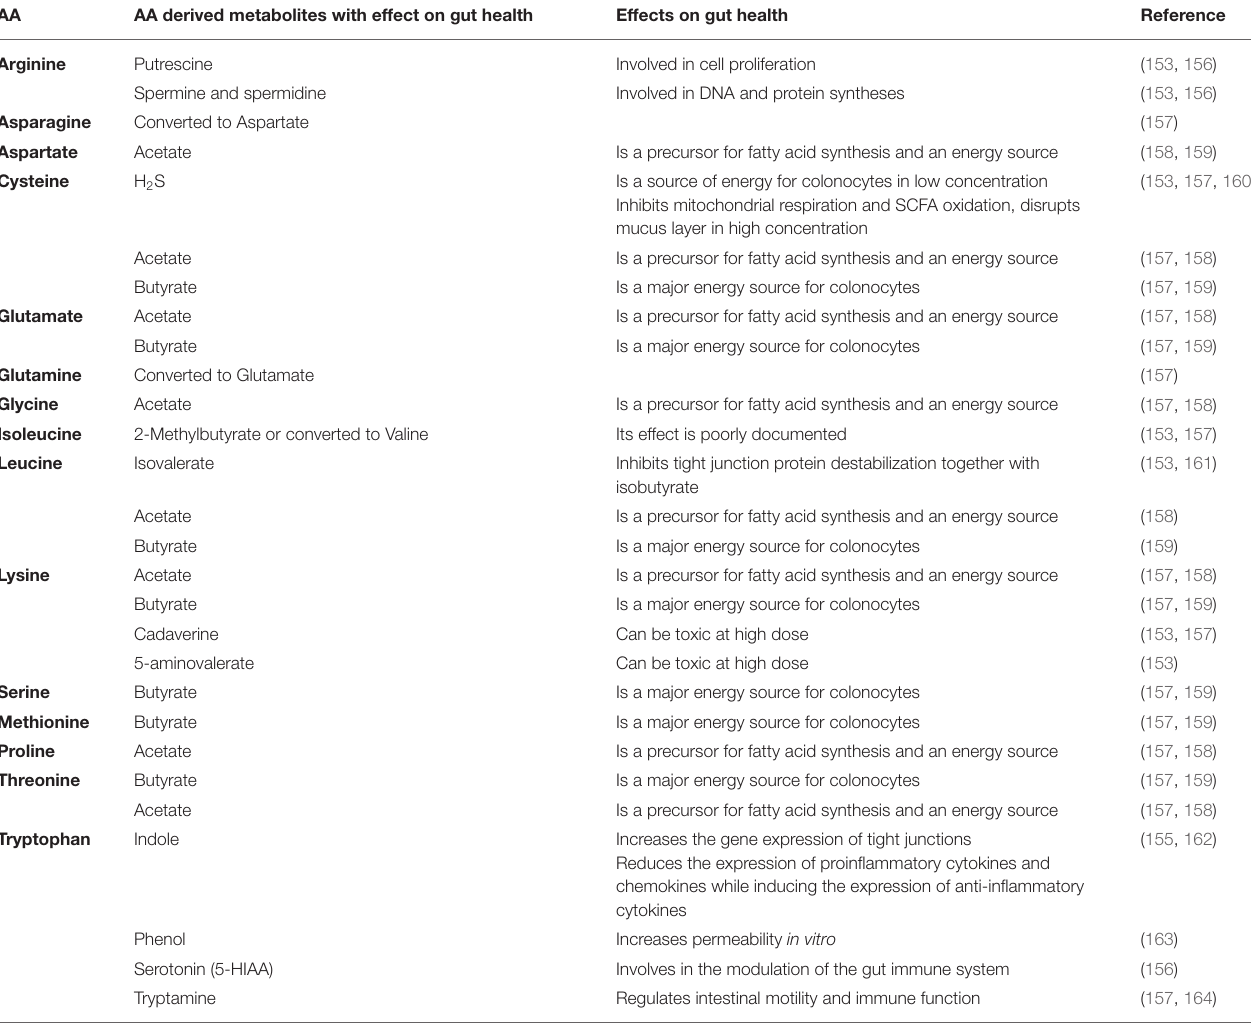
TABLE 3 | Main metabolites produced by amino acid metabolism by the in the gut microbiota and associated effect on gut health.